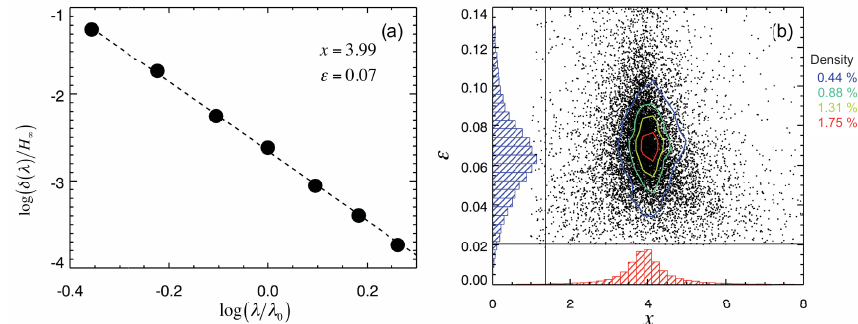
Figure 6. (a) An example of the linear regression between log δ(λ) scatter plot of x vs. ε for all pixels, joint PDFs p(x , ε) (contours) as well as the marginal PDFs p(x) and p(ε) (histograms). The peak of p(x , ε) , and thus the most likely { x,ε } values for the cloud field, is located at {3.85, 0.065}, and the domain-averaged values are {3.91, 0.070}.